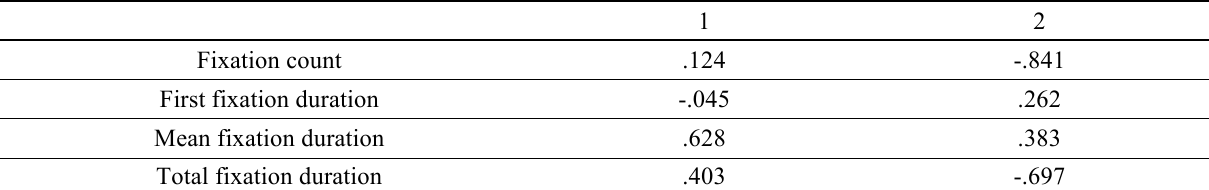
Table 3. Discriminant function coefficients for each DV index and